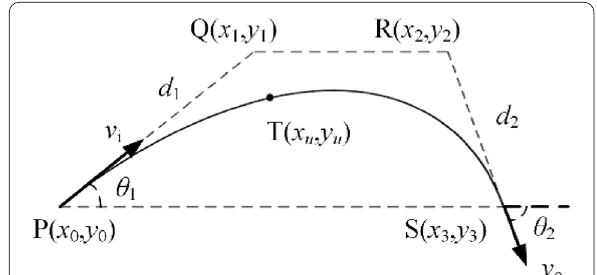
Figure 12 Example of the Bezier